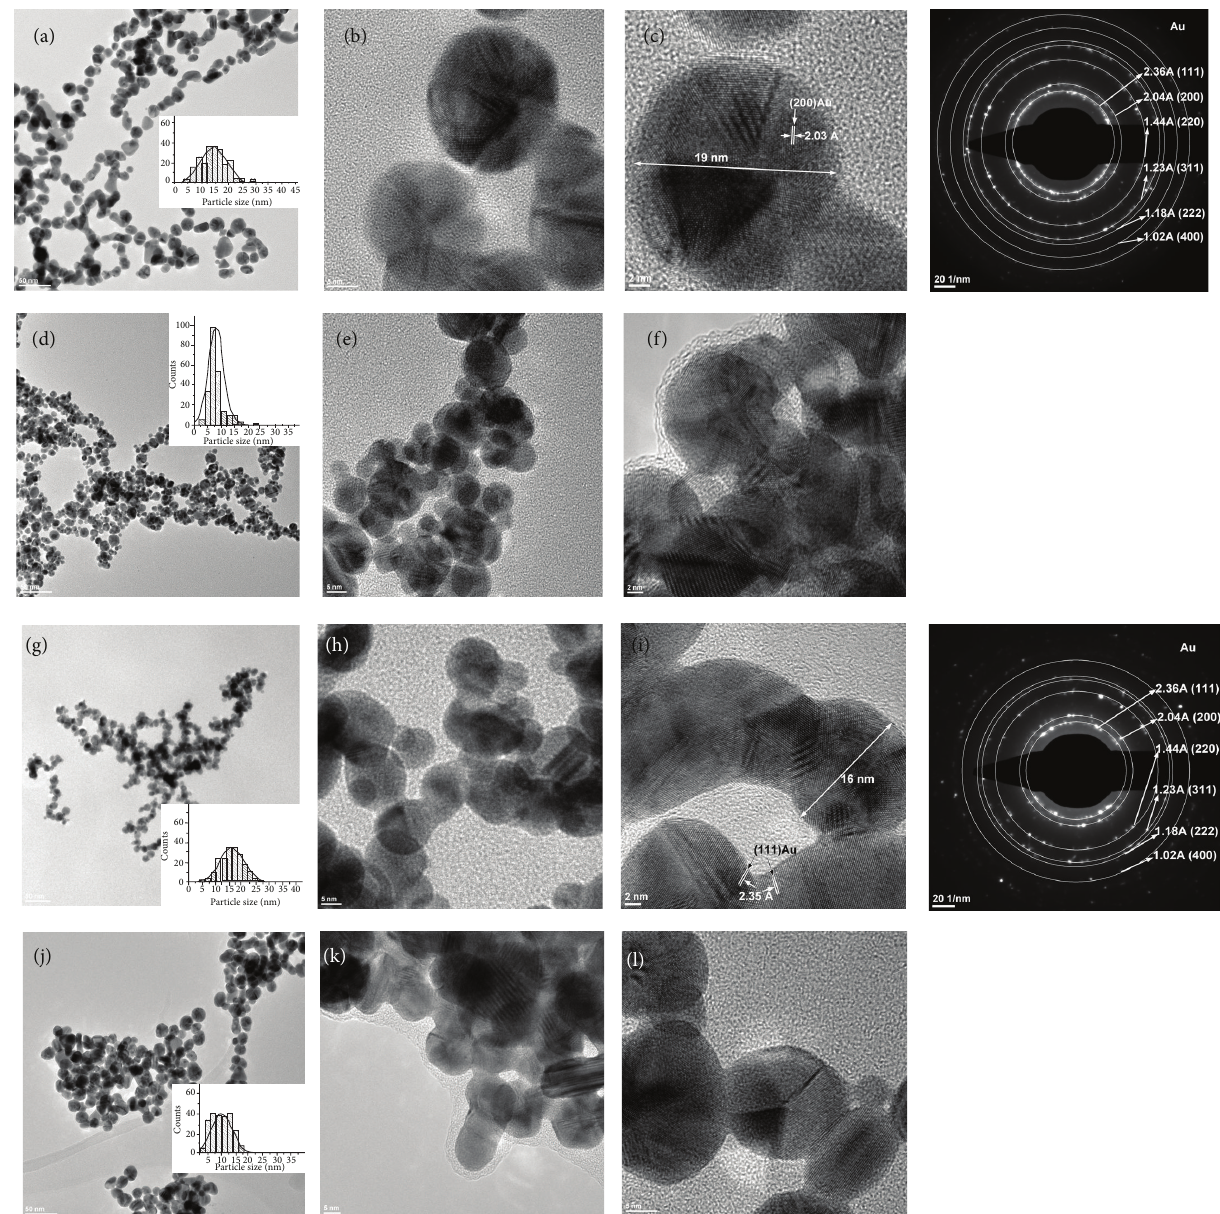
Figure 3: TEM and HR-TEM micrographs of (a)–(c): Au-G4-5; (d)–(f): Au-G4-2.5; (g)–(i): Au-G6-5; (j)–(l): Au-G6-2.5 nanocomposites after 48 hours. Specific size-distribution histograms were included. SAED results are representative for gold (fcc) polycrystalline structures.